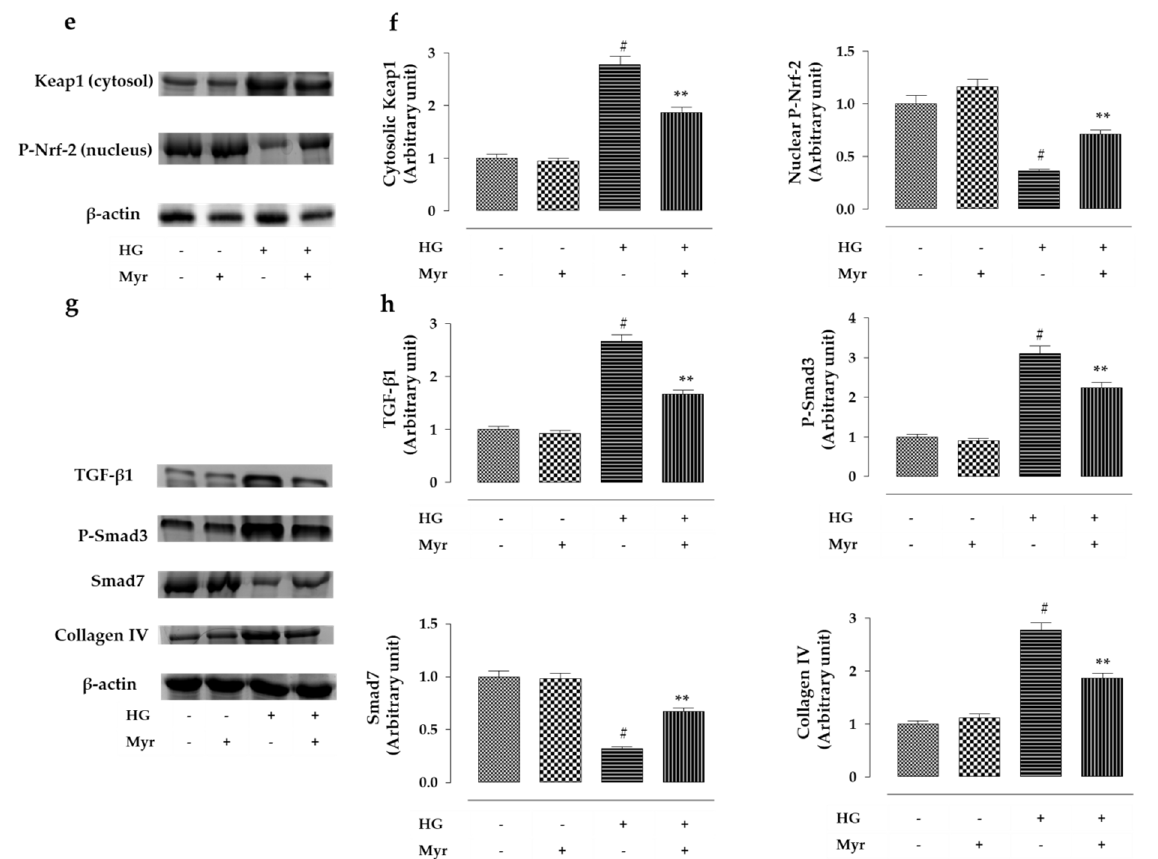
Figure 5. The effects of Myr on HG-induced signaling on NRK cells. ( a ) The immunoblot images showing the effects on the expressions of Bad (in mitochondria), Bcl-2, Cyt C (in cytosol), cleaved caspase 9, and cleaved caspase 3 involved in apoptosis. ( b ) The graphs showing the densitometric analysis of the bands of apoptotic factors. ( c ) The immunoblot images showing the effects on the expressions of P-I κ B α (in cytosol), and P-NF- κ B (in nucleus) involved in inflammation. ( d ) The graphs showing the densitometric analysis of the bands of inflammatory factors. ( e ) The immunoblot images showing the effects on the expressions of Keap1 (in cytosol), and P-Nrf-2 (in nucleus) involved in redox defense. ( f ) The graphs showing the densitometric analysis of the bands of redox defense factors. ( g ) The immunoblot images showing the effects on the expressions of TGF- β 1, P-Smad3, Smad7, and collagen IV involved in fibrosis. ( h ) The graphs showing the densitometric analysis of the bands of fibrotic factors. Myr was effective in reducing HG-induced increase in the expressions of Bad (in mitochondria), Cyt C (in cytosol), cleaved caspase 9, cleaved caspase 3, P-I κ B α (in cytosol), and P-NF- κ B (in nucleus), Keap1 (in cytosol), TGF- β 1, P-Smad3, and collagen IV, while it activated the expressions of Bcl-2, P-Nrf-2 (in nucleus), and Smad7. The intensity of normal control band was assigned 1. β -actin served as the loading control for normalization. Data are represented as the mean ± SD, n (number of plates) = 3. # Values significantly ( p < 0.01) differed from the control (HG − ) group. ** Values significantly ( p < 0.01) differed from the HG-treated (HG+) group.